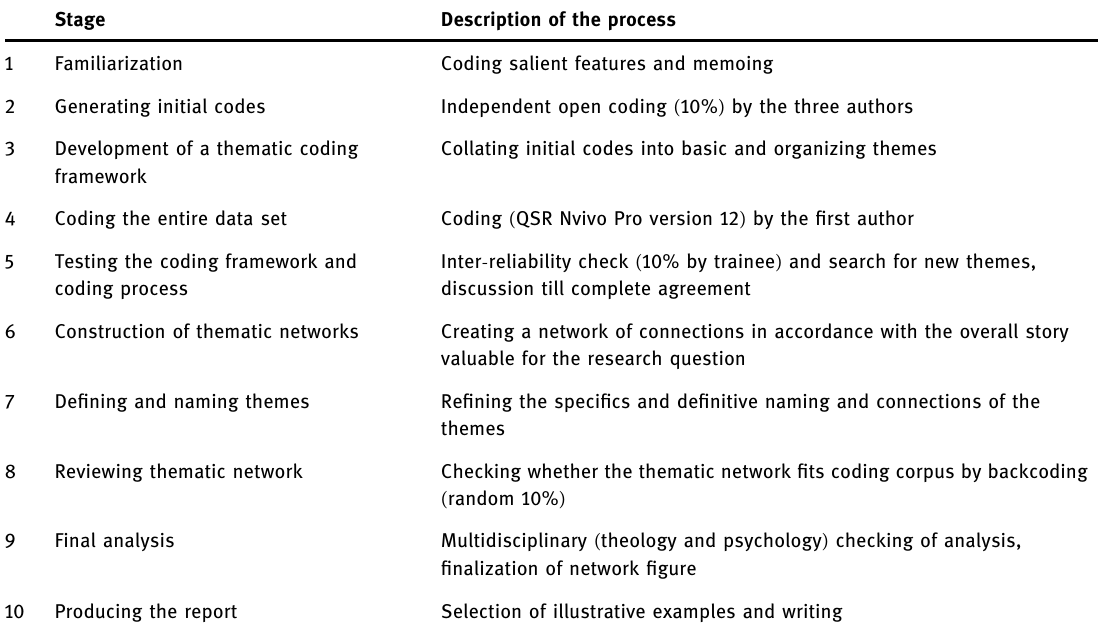
Table 1: Description of the stages in the data analysis a